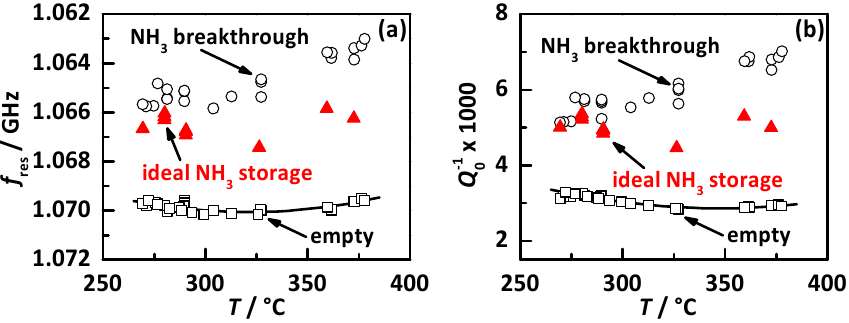
Figure 7. RF signals as function of catalyst temperature for the empty state (black squares), the NH 3 breakthrough (black circles) and the ideal NH 3 storage degree (red triangles): ( a ) the resonance frequency f res in reverse scale and ( b ) the reciprocal quality factor Q 0 − 1 .